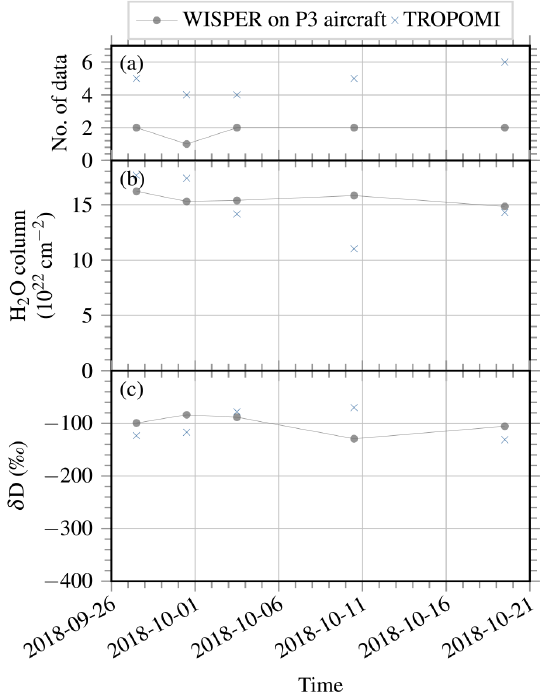
Figure 15. Time series of (a) the number of measurements, (b) daily averaged total columns of H 2 O and (c) δ D from aircraft profiles (grey) and co-located TROPOMI retrievals